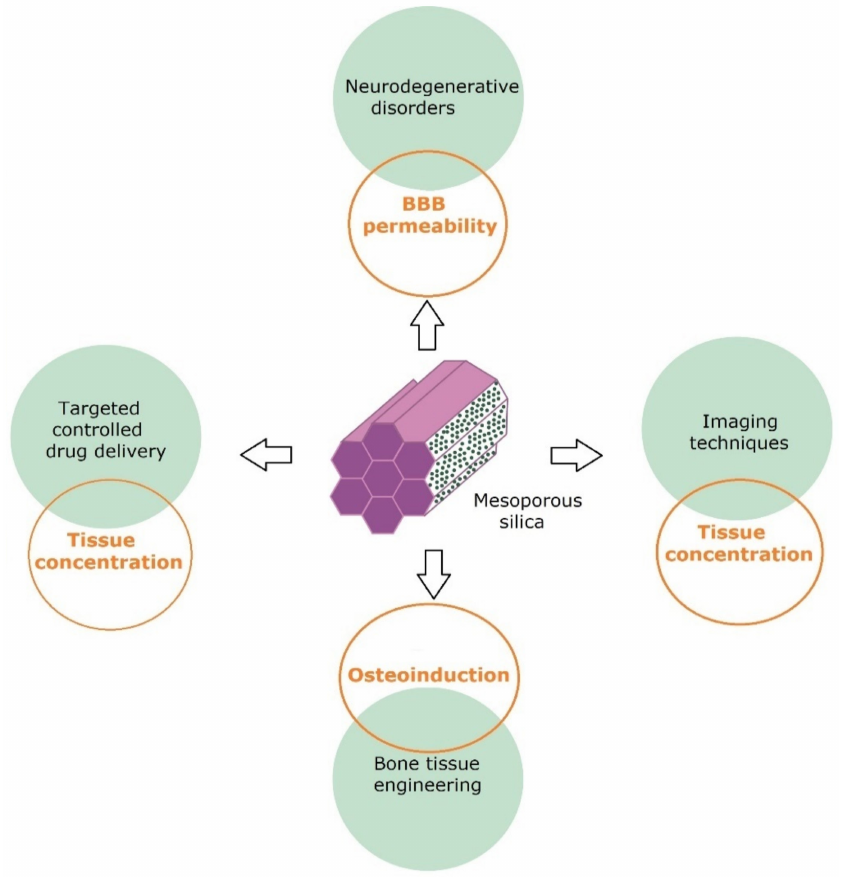
Figure 4. Mesoporous silica applications and main challenges in their